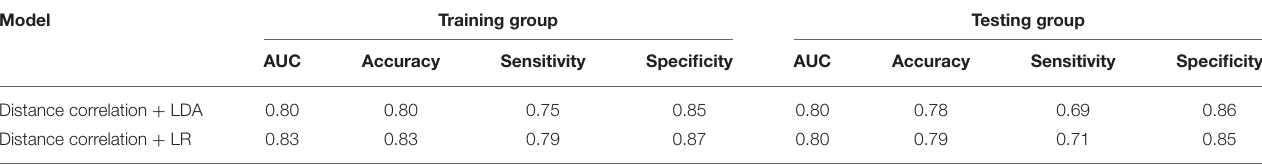
TABLE 1 | Results of the optimal discriminative model in distinguishing GBM from MBTs in the training and the testing groups. Model Training group Testing group AUC Accuracy Sensitivity Specificity AUC Accuracy Sensitivity Specificity Distance correlation + LDA